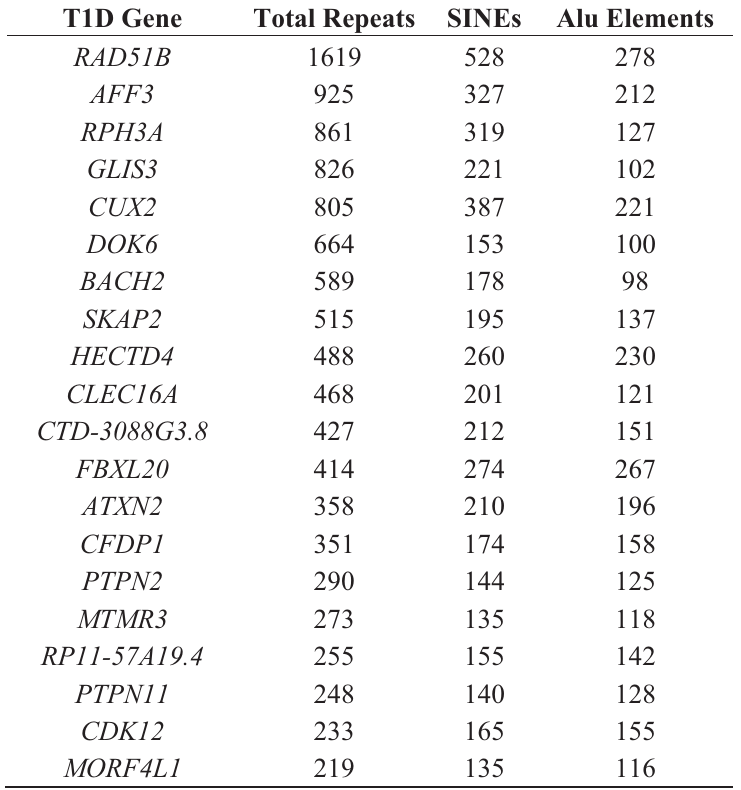
Table 3. Top 20 T1D genes based on total number of repeats and Alu elements. The top 20 T1D candidate genes based on total number of repeats, SINE elements, and Alu repeats based on RepeatMasker v. 4